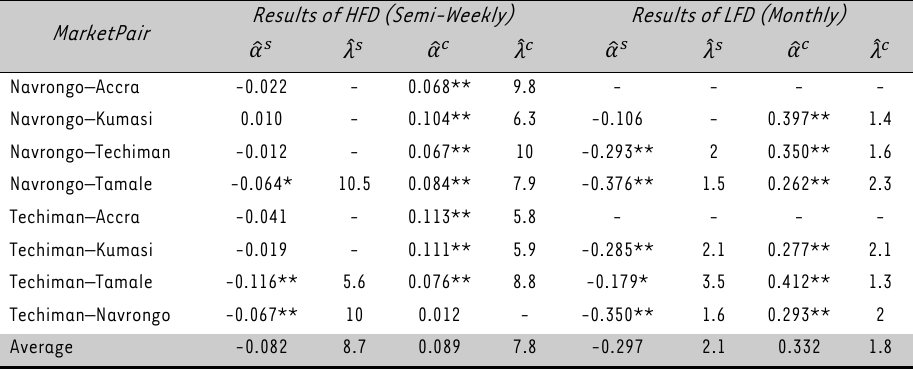
Results of the Standard Vector Error Correction Model Results of HFD (Semi-Weekly) Results of LFD MarketPair